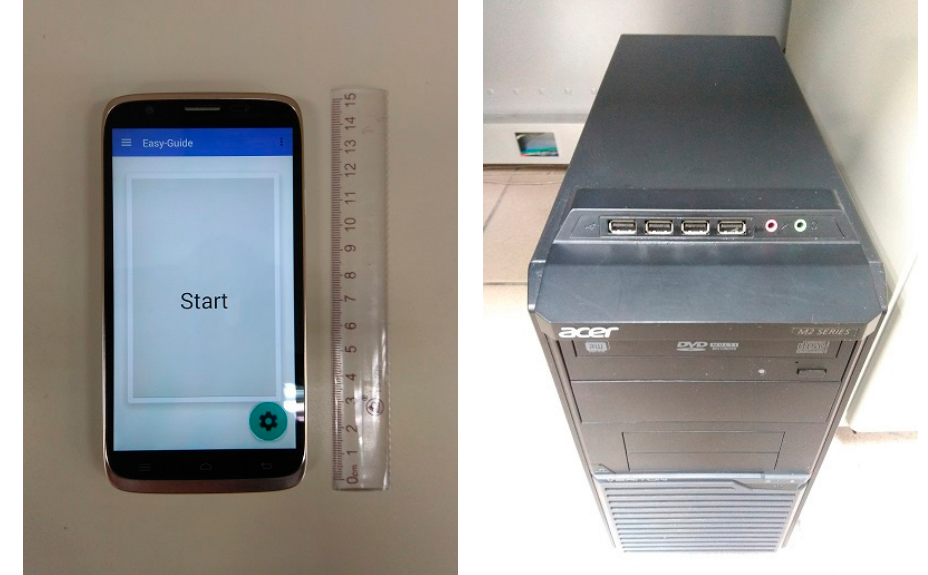
Figure 1. Photograph of the smartphone ( left ) and server ( right ).